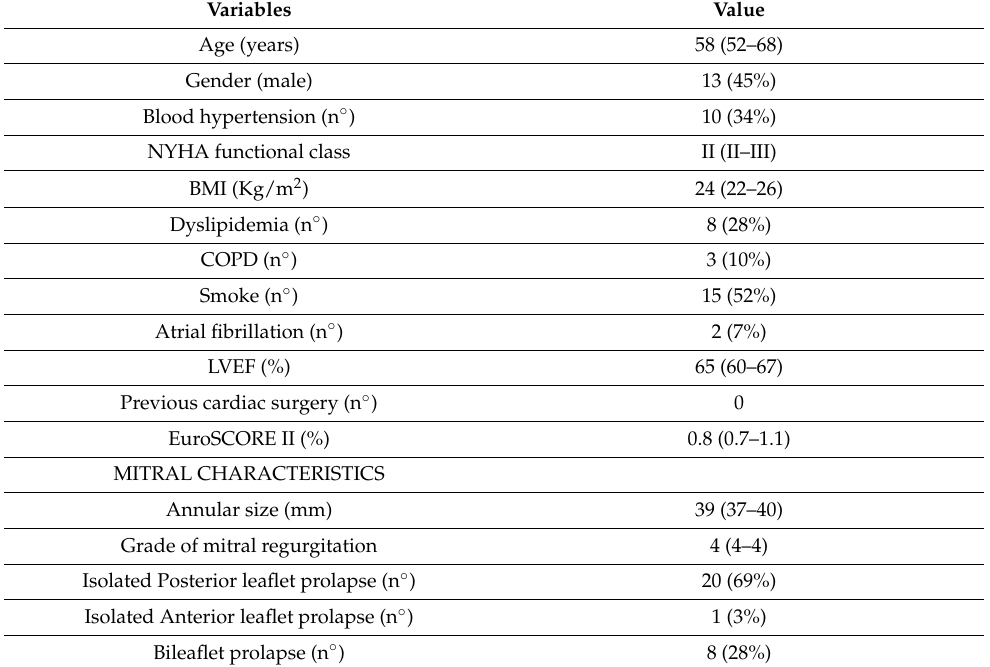
Table 2. Pre-operative characteristics.